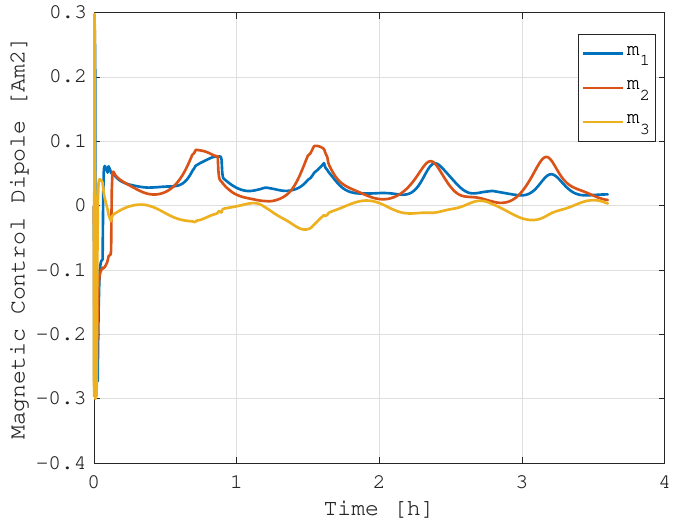
Figure 5. Actuated magnetic dipole in inertial pointing control.